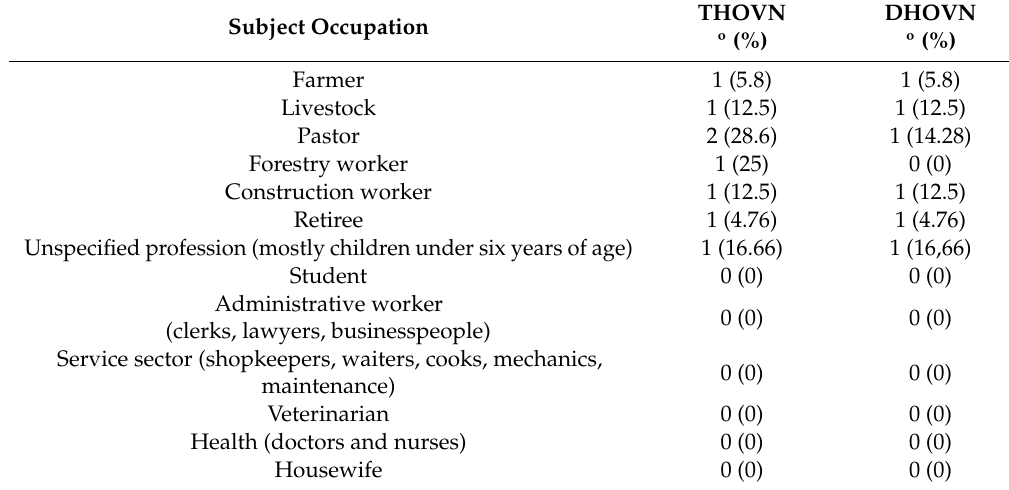
Table 3. Seroprevalence with respect to subject occupation.